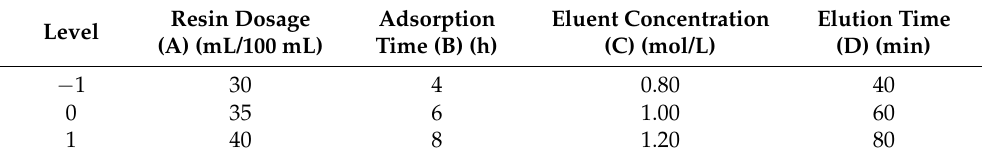
Table 1. Factors and their levels employed in the Box–Behnken experimental